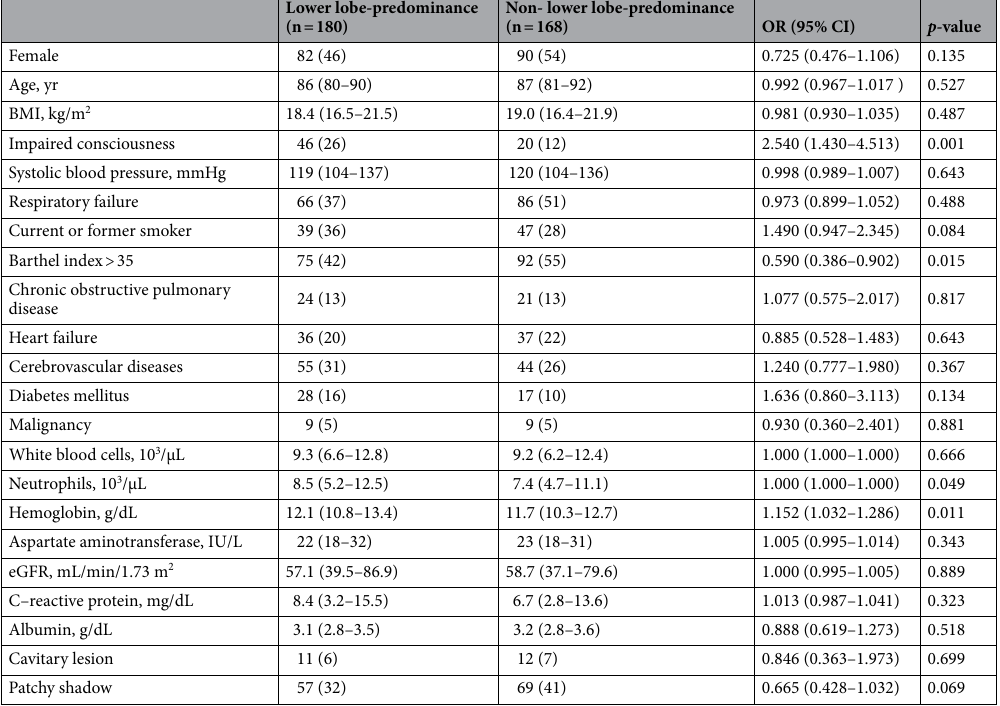
Table 1. Univariate logistic regression analysis of the baseline characteristics associated with lower lobe- predominant distribution. Data are presented as number (%) or median (interquartile range). BMI, body mass index; CI, confidence interval; eGFR, estimated glomerular filtration rate; OR, odds ratio.